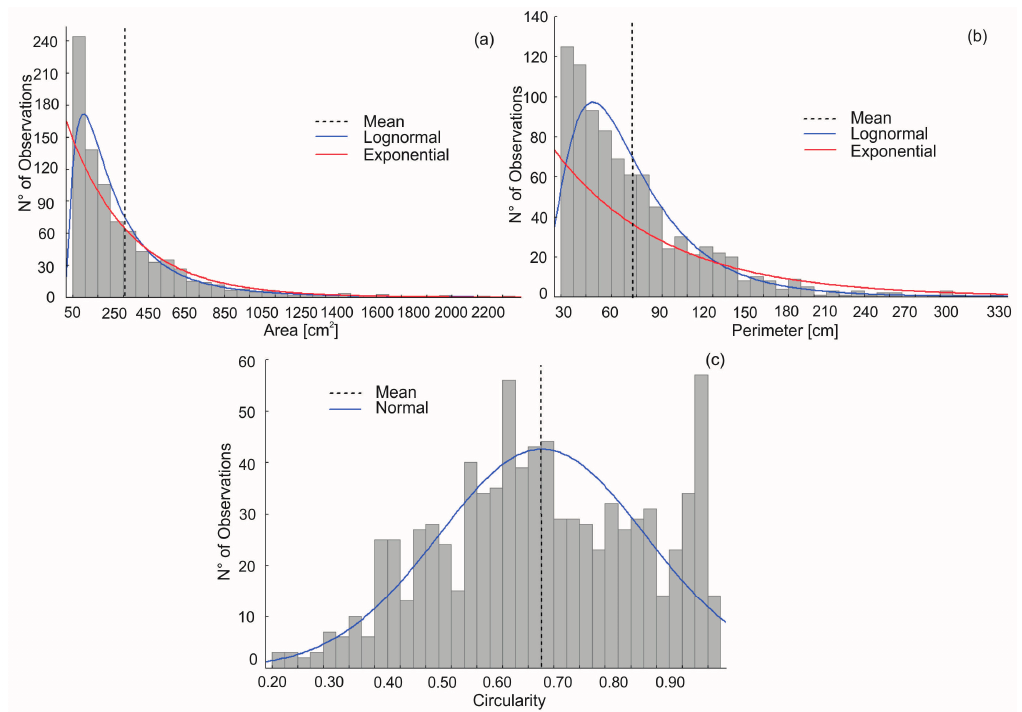
Figure 6. Frequency histograms of the bioerosion features variables. ( a ) Area; ( b ) Perimeter; ( c ) Circularity.